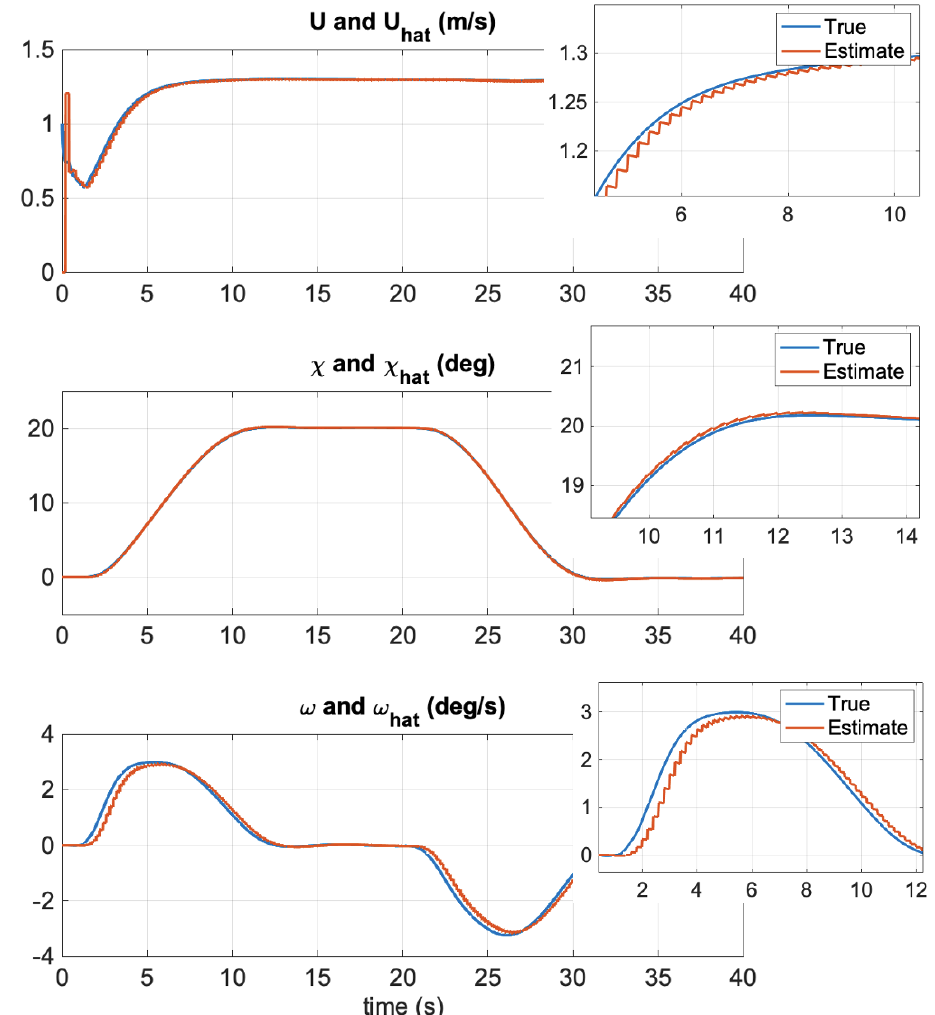
Figure 6. Simulation study: Estimated SOG, COG, and course rate versus time. The zoomed plots to the right show the slow GNSS rate (5 Hz) compared to the EKF sampling time (50 Hz). The autopilot performed a 20 degrees course command, which was returned to 0 degrees at time t = 20